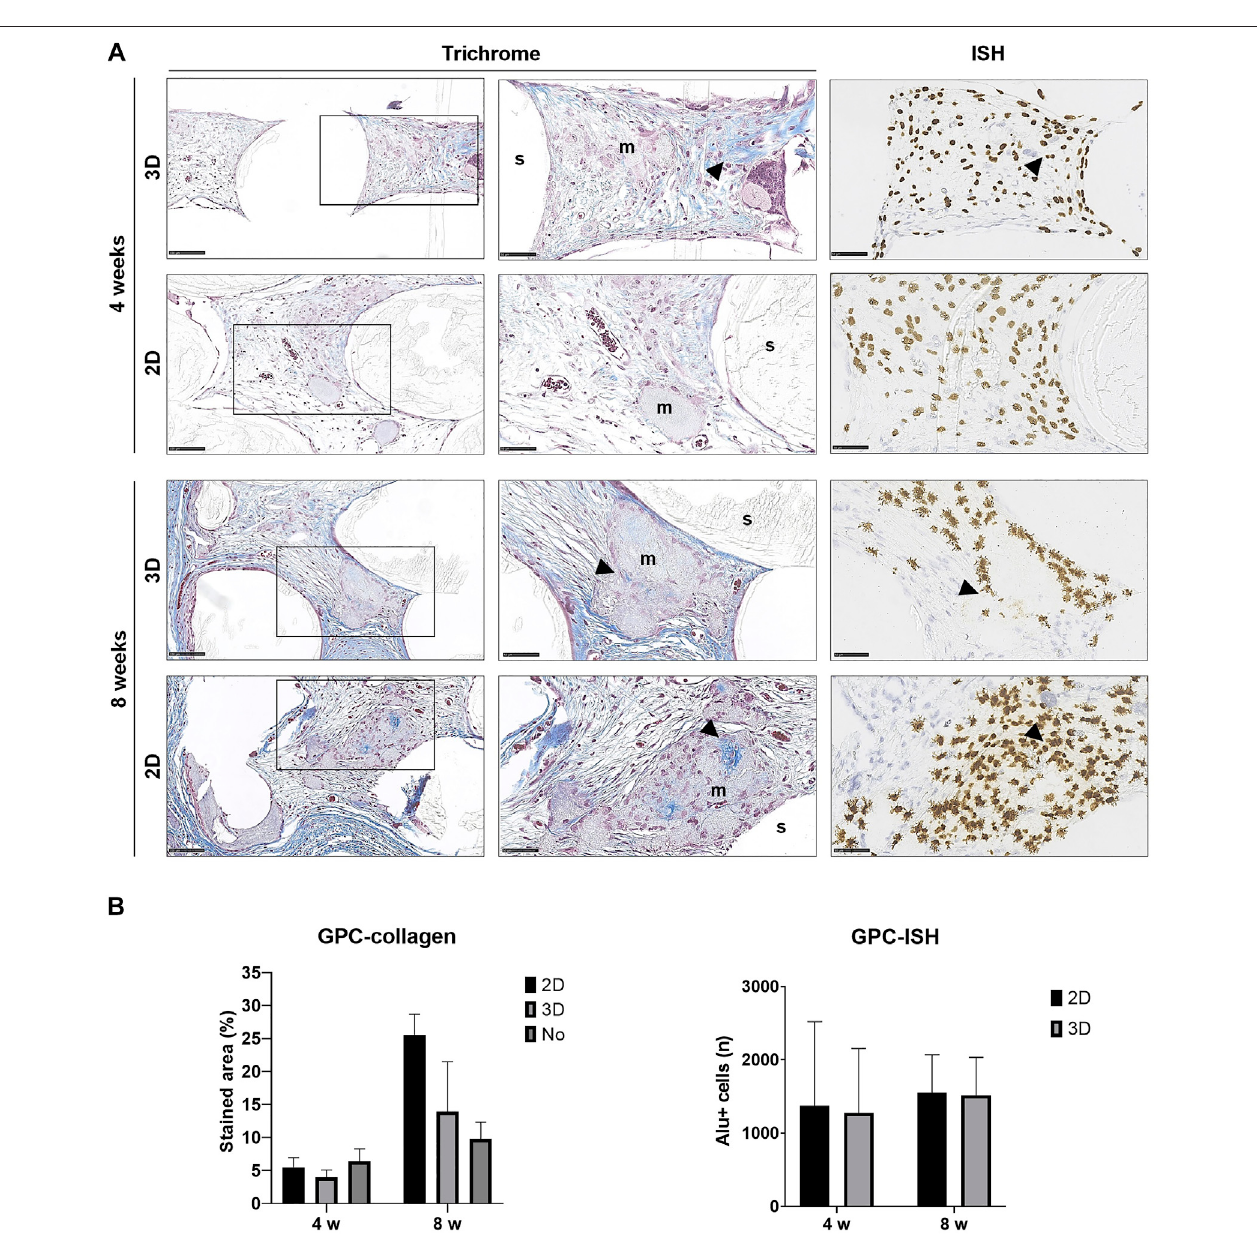
FIGURE 5 | Histology of GPC constructs. (A) Representative images of Trichrome and corresponding ISH stained sections of 2D and 3D GPC constructs after 4 and 8 weeks; m, mineralization; s, scaffold; arrows indicate dense collagen (Trichrome) and Alu + cells (ISH); scale bars 100 μ m. (B) Quanti fi cation of collagen staining (Trichrome) and Alu + cells (ISH); n, total number; data represent means ± SD ( n (cid:1) 3).